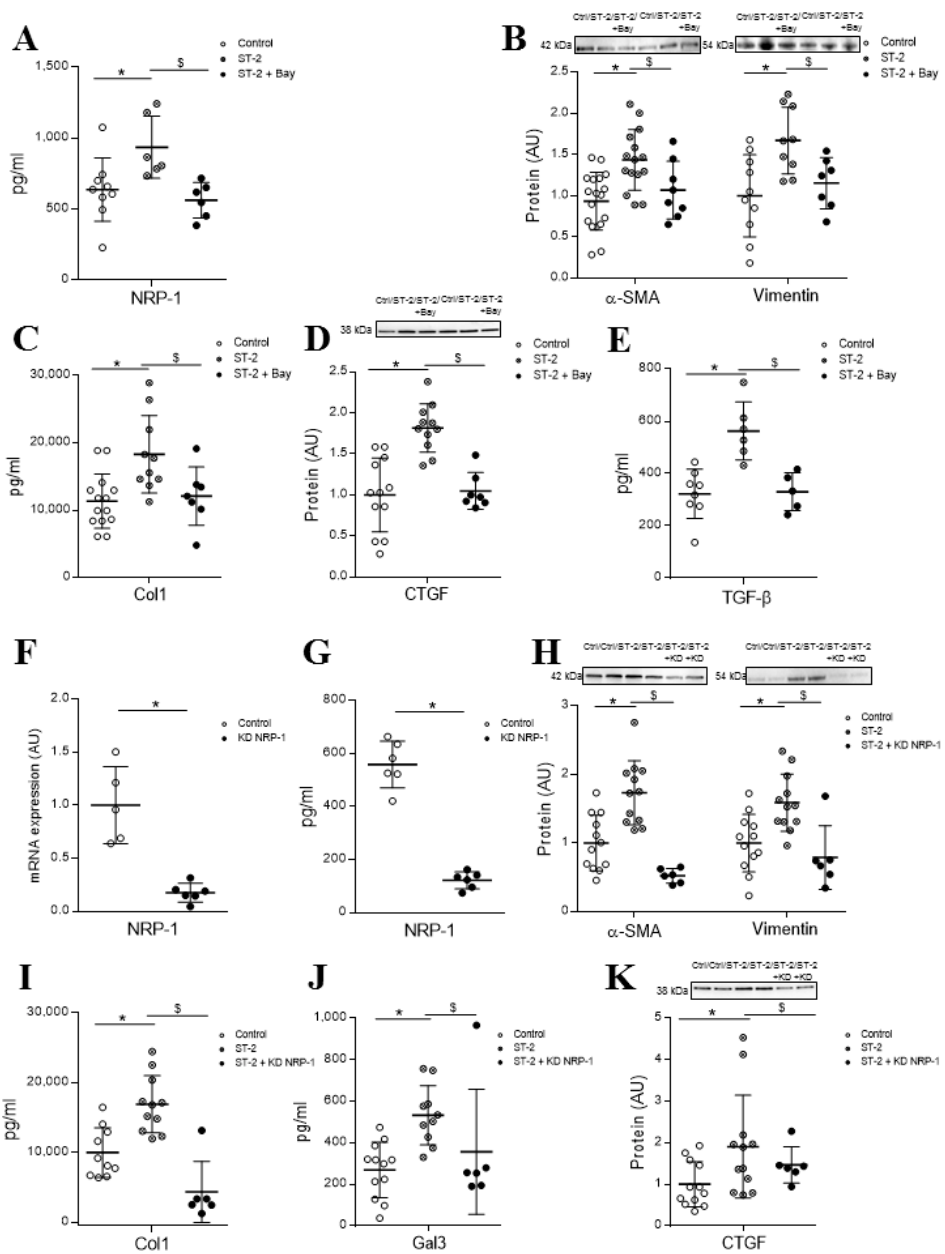
Figure 3. Intracellular pathways regulated by sST2 to promote its profibrotic effects. Nuclear factor-kappa B (NF- κ B) mediates sST2 effects on NRP-1 expression ( A ), myofibroblast activation markers α -SMA and vimentin ( B ), profibrotic molecules Col-1 ( C ), CTGF ( D ) and TGF- β 1 ( E ). Expression of NRP-1 at transcript ( F ) and protein ( G ) levels in NRP-1 knockdown HCFs. Induction of activation markers α -SMA and vimentin ( H ), Col-1 secretion ( I ) and the profibrotic molecules Gal-3 ( J ) and CTGF ( K ) by ST2 in NRP-1 knockdown HCFs. Scatter dot blots represent median and minimum to a maximum range of N = 5-18 replicates per condition. For Western blot experiments, protein densitometry was expressed in arbitrary units (AU) once normalized to stain-free for proteins. Relative mRNA expression is expressed in arbitrary units (AU) of the fold change after normalization to HPRT, β -actin and GADPH housekeeping genes. Representative blots have been displayed when appropriate. * p < 0.05 vs. control. $ p < 0.05 vs. sST2. Statistical significance was studied by a one-way ANOVA analysis. NRP-1, neuropilin 1; α -SMA, alpha smooth muscle actin; Col-1, collagen type I; CTGF, connective tissue growth factor; TGF- β 1, transforming growth factor beta and Gal-3,